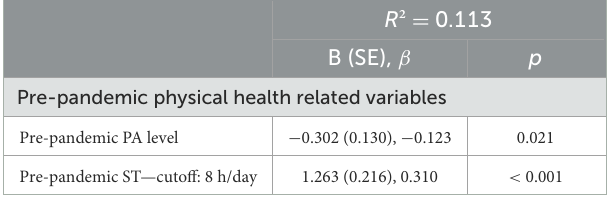
TABLE 3 Significant predictors of the change in sedentary time from before to during the pandemic (2020) in a linear regression analysis. R ² =